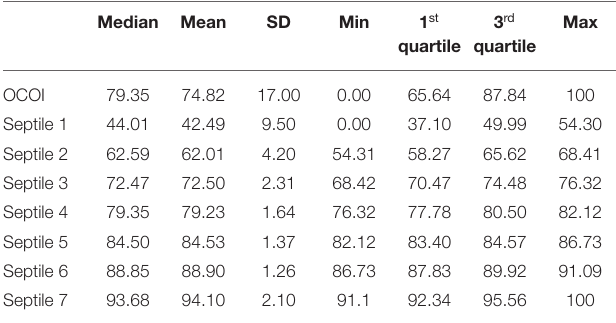
TABLE 2 | Summary of Ohio children’s opportunity index scores and domains. Median Mean